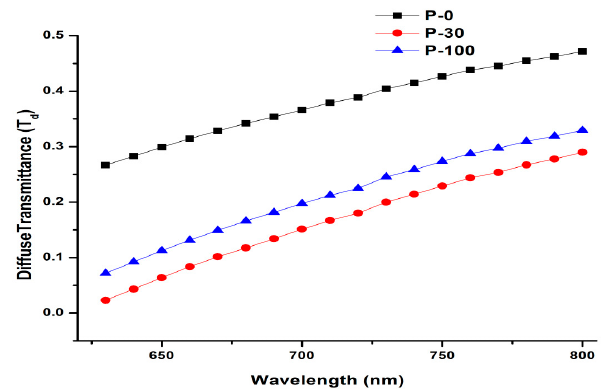
Figure 2. Variation in diffuse transmittance by increasing the wavelength from 600 nm to 800 nm with radiation dosage 0, 30 kGy, and 100 kGy.